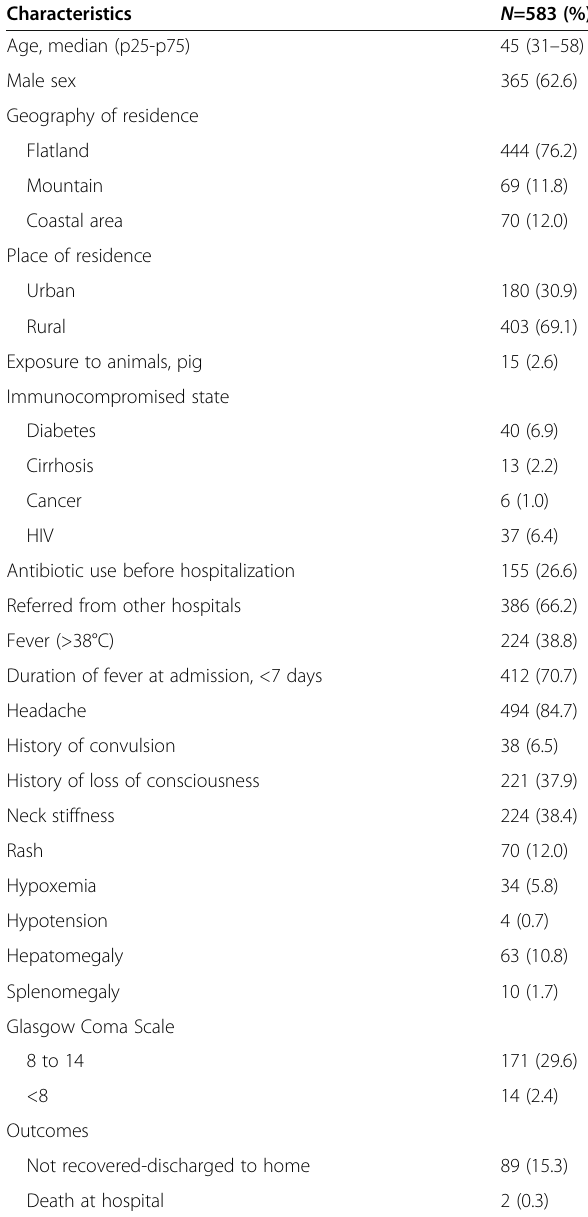
Table 1 Epidemiological and clinical characteristics of study